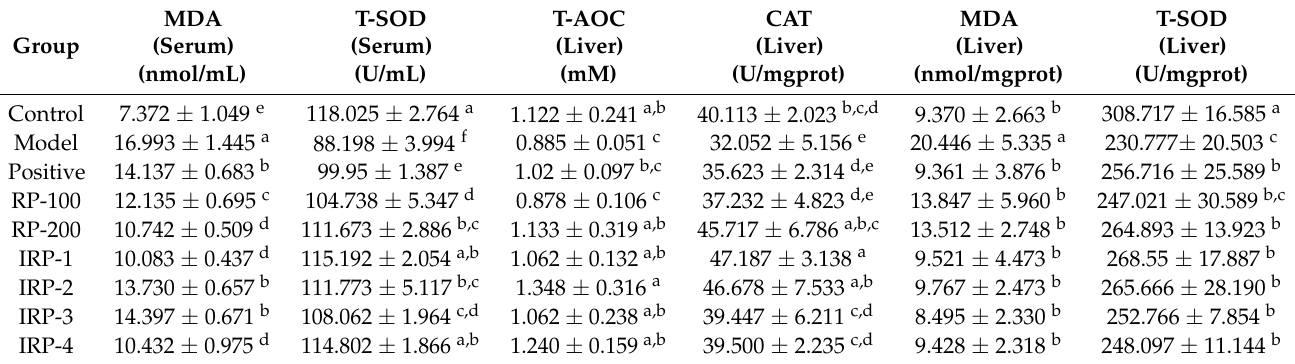
Table 2. Effects of RP and IRP 1–4 on oxidative stress in db/db mice of 0 and 8